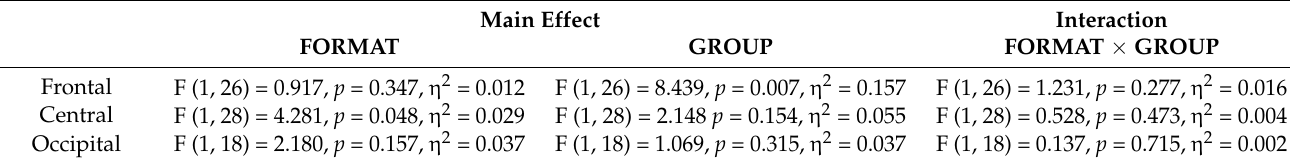
Table 3. p -values and related statistical parameters for each ANOVA.